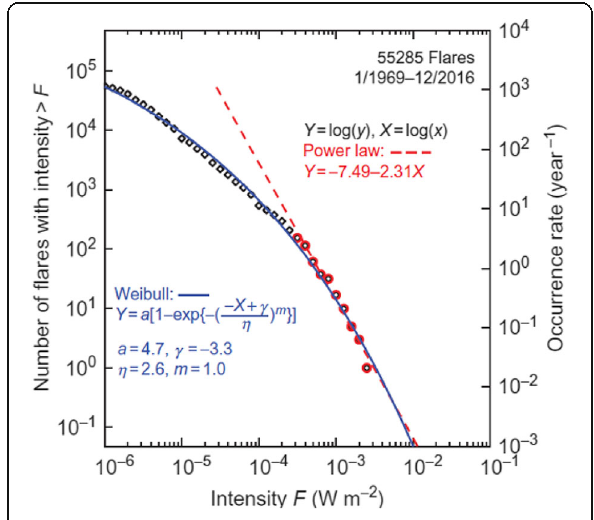
Fig. 6 Cumulative distribution of flare sizes between 1969 and